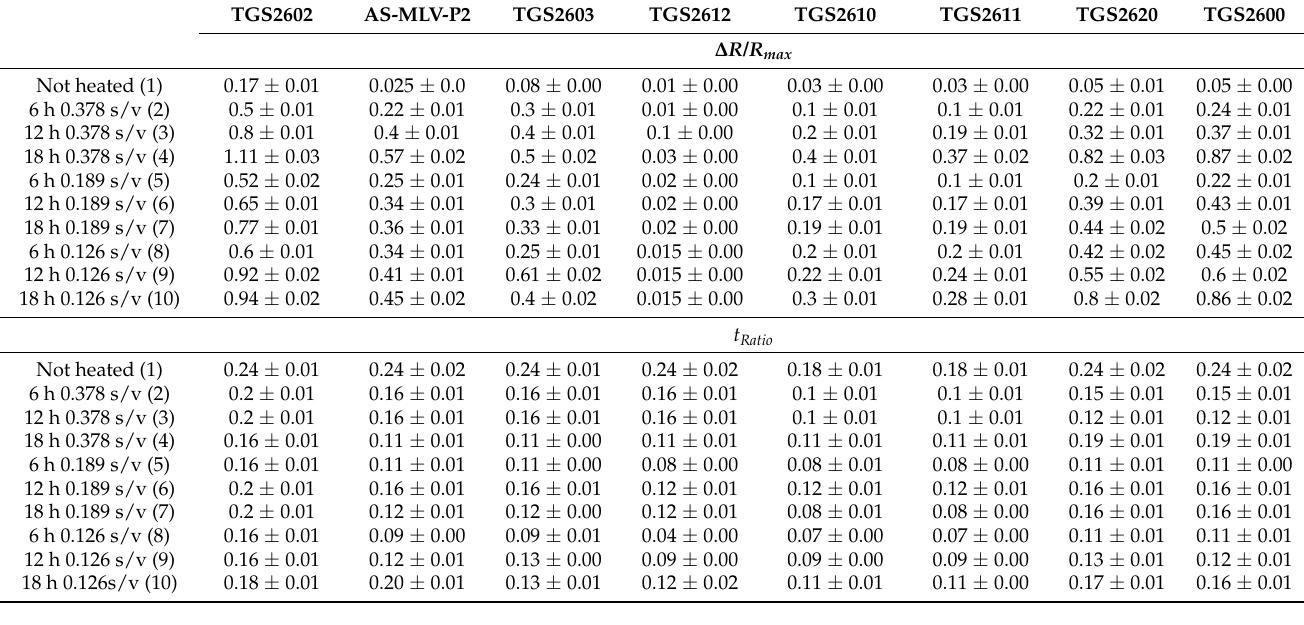
Table 3. Responses of metal oxide semiconductor chemoresistors to the odour profile of heated oil.